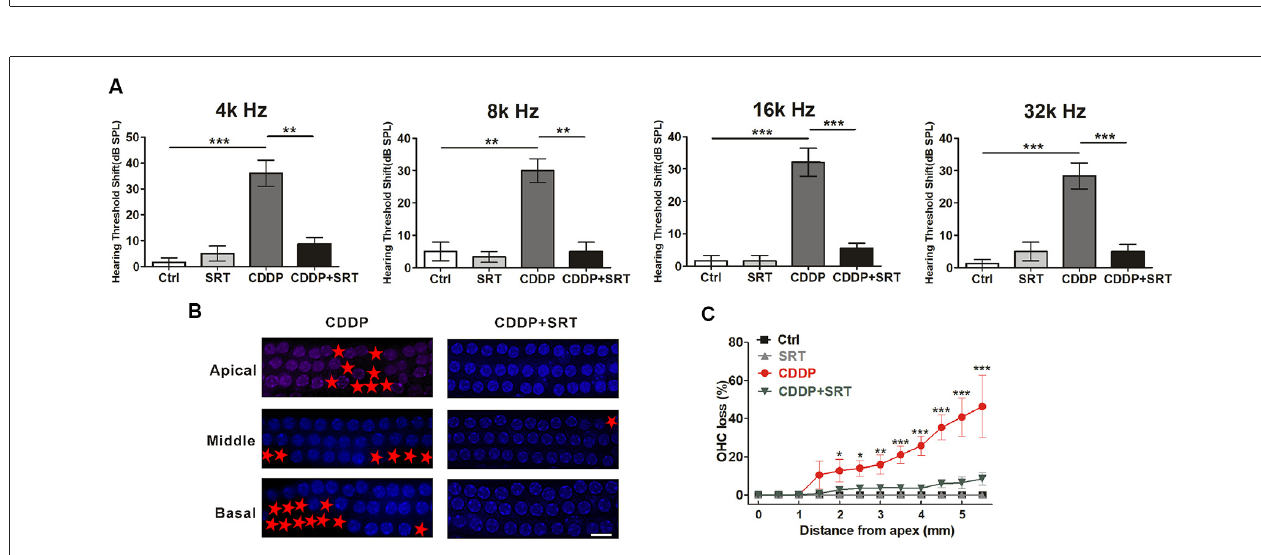
FIGURE 7 | SIRT1 activation attenuates cisplatin-induced hair cell loss and hearing loss in C57BL/6 mice. (A) ABR thresholds decreased with SRT1720 (100 mg/kg, intragastric administration pre-12 h, pre-1 h, post-12 h) treatment mice following CDDP (16 mg/kg, intraperitoneal injection) exposure compared with the CDDP group at 4, 8, 16 and 32 kHz ( n = 6 mice). (B,C) Surface preparations were stained with DAPI. Hair cell counts obtained from the CDDP and CDDP+SRT1720 group ( n = the right cochlea of six mice). Scale bar, 10 µ m. Data represent the mean ± SEM. ∗ p < 0.05, ∗∗ p < 0.01, ∗∗∗ p < 0.001. Control, mice intraperitoneally injected with the same dose DMSO as the CDDP group; SRT1720, mice gavage SRT1720 three times; CDDP, mice intraperitoneally injected with CDDP; CDDP + SRT1720, mice intraperitoneal injected with CDDP once and gavage SRT1720 three times. CDDP, cisplatin; SRT, SRT1720; Apical, the apical turn; Middle, the middle turn; Basal, the basal turn; Red asterisks, lost hair